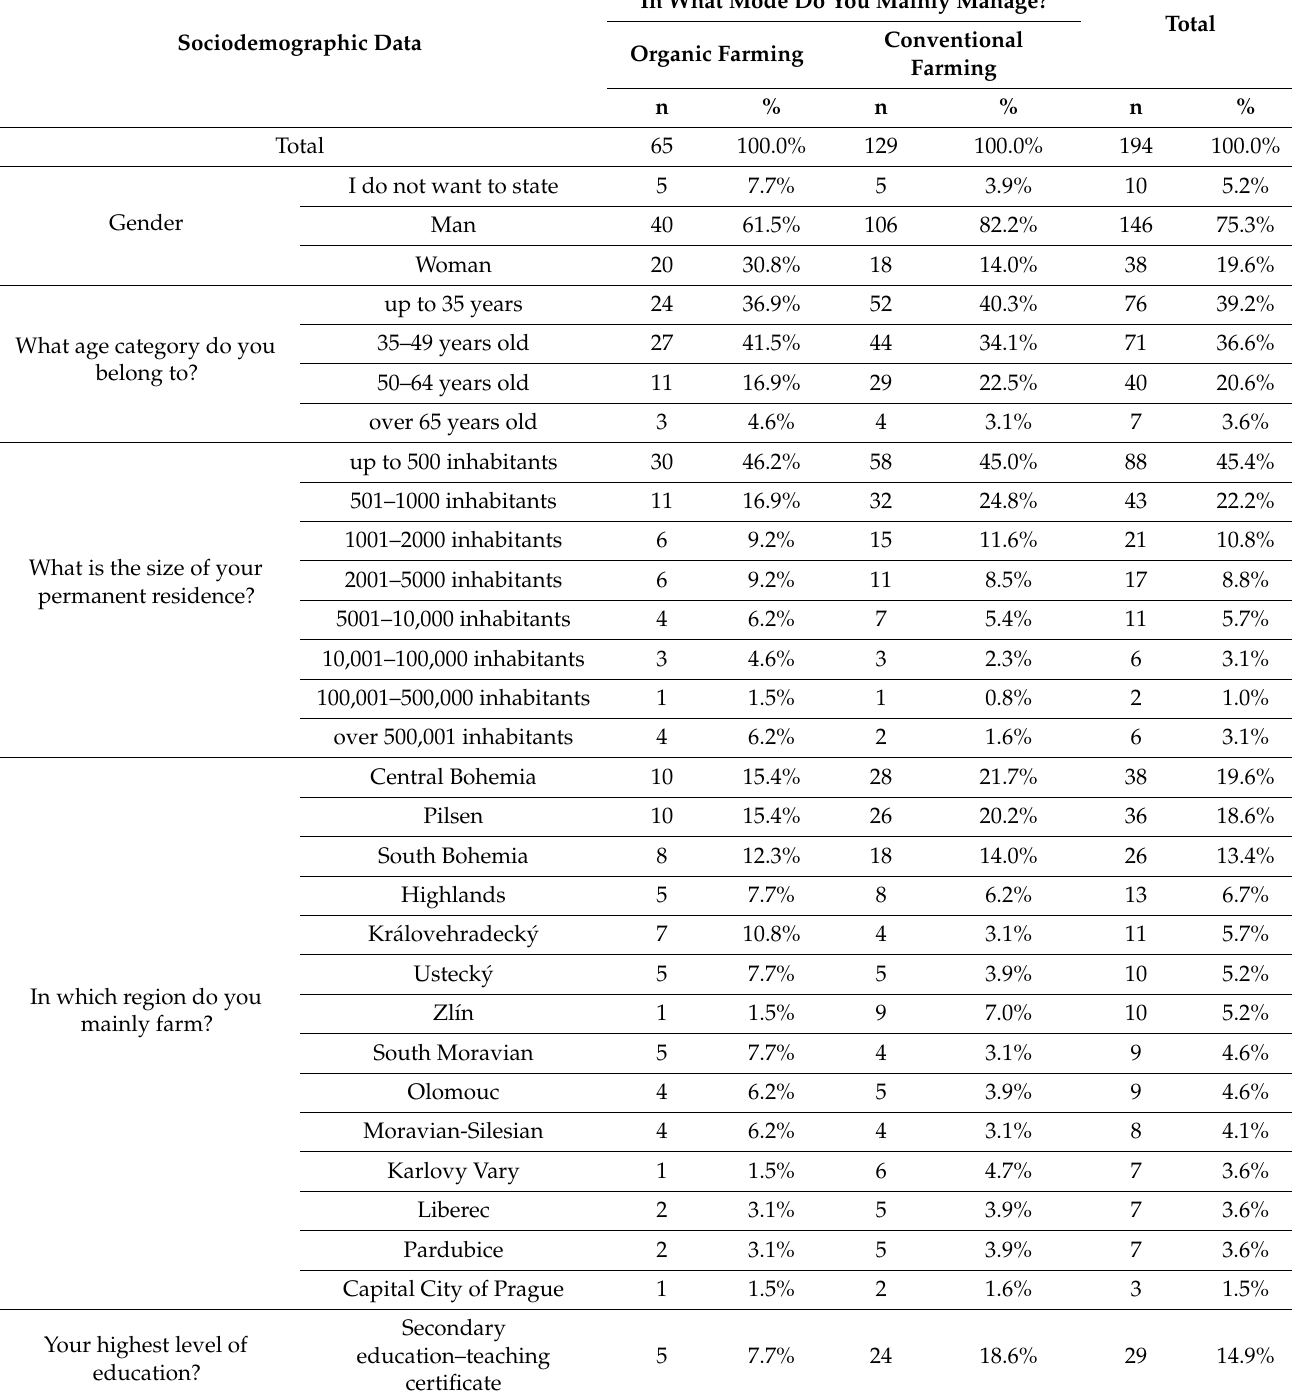
Table 1. Sociodemographic data of respondents by farming